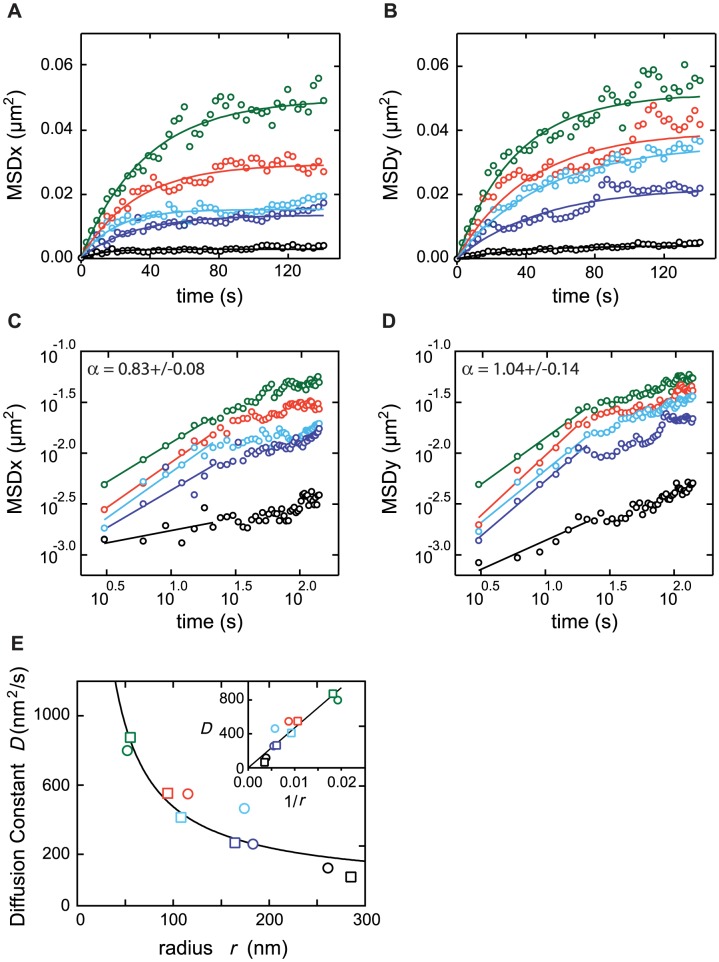
Size-dependence of the diffusion constants.Trajectories from the LF movies (Fig. 2) were clustered into 5 classes of increasing initial median fluorescence (Table 1) and the corresponding MSD were averaged in each class. Symbols (open circles) show the MSD for the x- (A) and y-directions (B) for each class. Curve colors correspond to the classes from Table 1(with median fluorescence increasing from top to bottom). The corresponding full lines show the results of the fitting procedure for each class (see text and Material and Methods). Panels (C) and (D) show the corresponding log-log plots, to explore for possible anomalous diffusion. The straight lines are linear fits over the initial regimes (first 21 seconds), before movement restriction starts saturating the MSDs. The slopes of these lines are the anomalous exponents as defined by MSD(t)∼tα. Each panel indicates the average (+/− s.d.) of the exponents determined for the 4 smallest aggregates classes (thus excluding the largest class, represented by black circles). The resulting values of the diffusion constant D are plotted against the radius r in (E), keeping the same color code as in (A–D). Full circles indicate the values determined from fitting the MSD in the x-direction, while full squares show the values from the fit in the y-direction. The full line is a fit to a Stock-Einstein law D(r) = C
0/r, yielding C0 = 47.23×103 nm3/s. The inset replots these data as a function of 1/r.